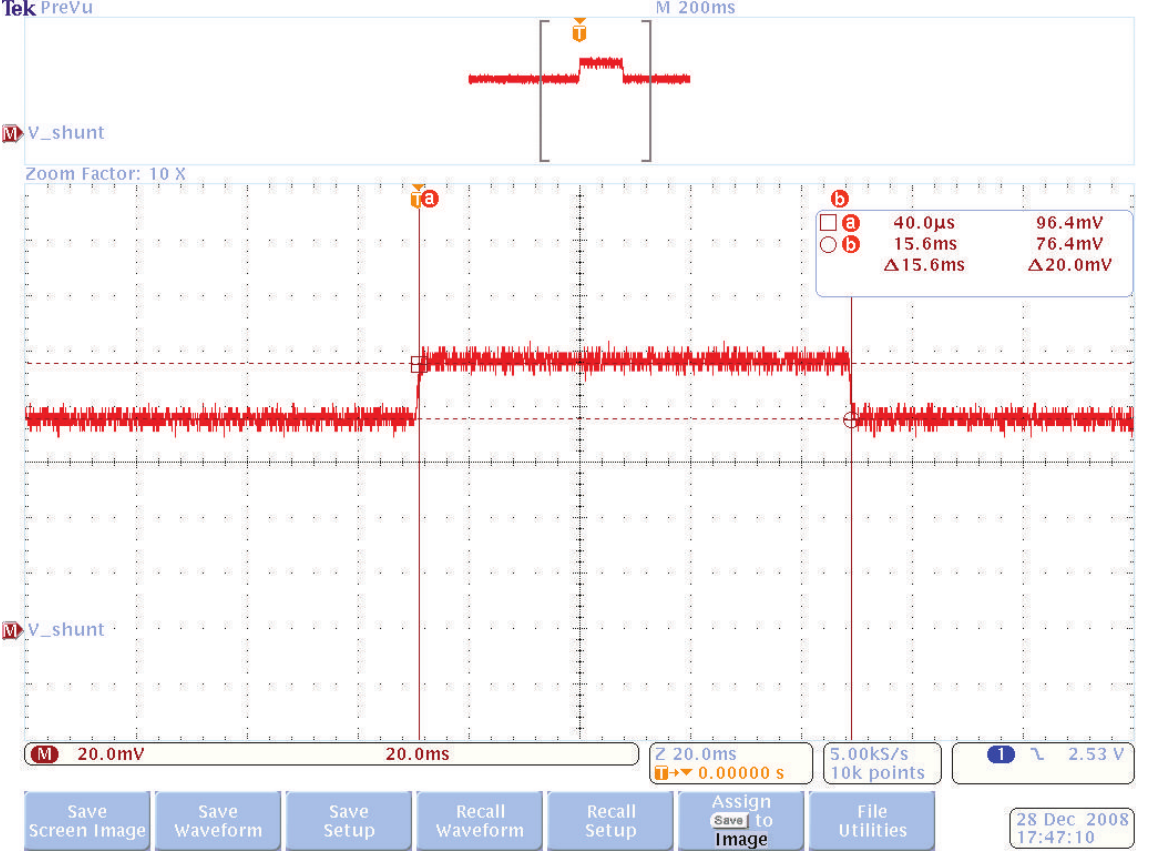
Figure 16: Power consumption for Virtex II Pro’s partial reconfiguration. The Y axis is voltage measured at the shunt resistors during the reconfiguration process according to setup shown in Figure 7. This figure is an oscilloscope screenshot.